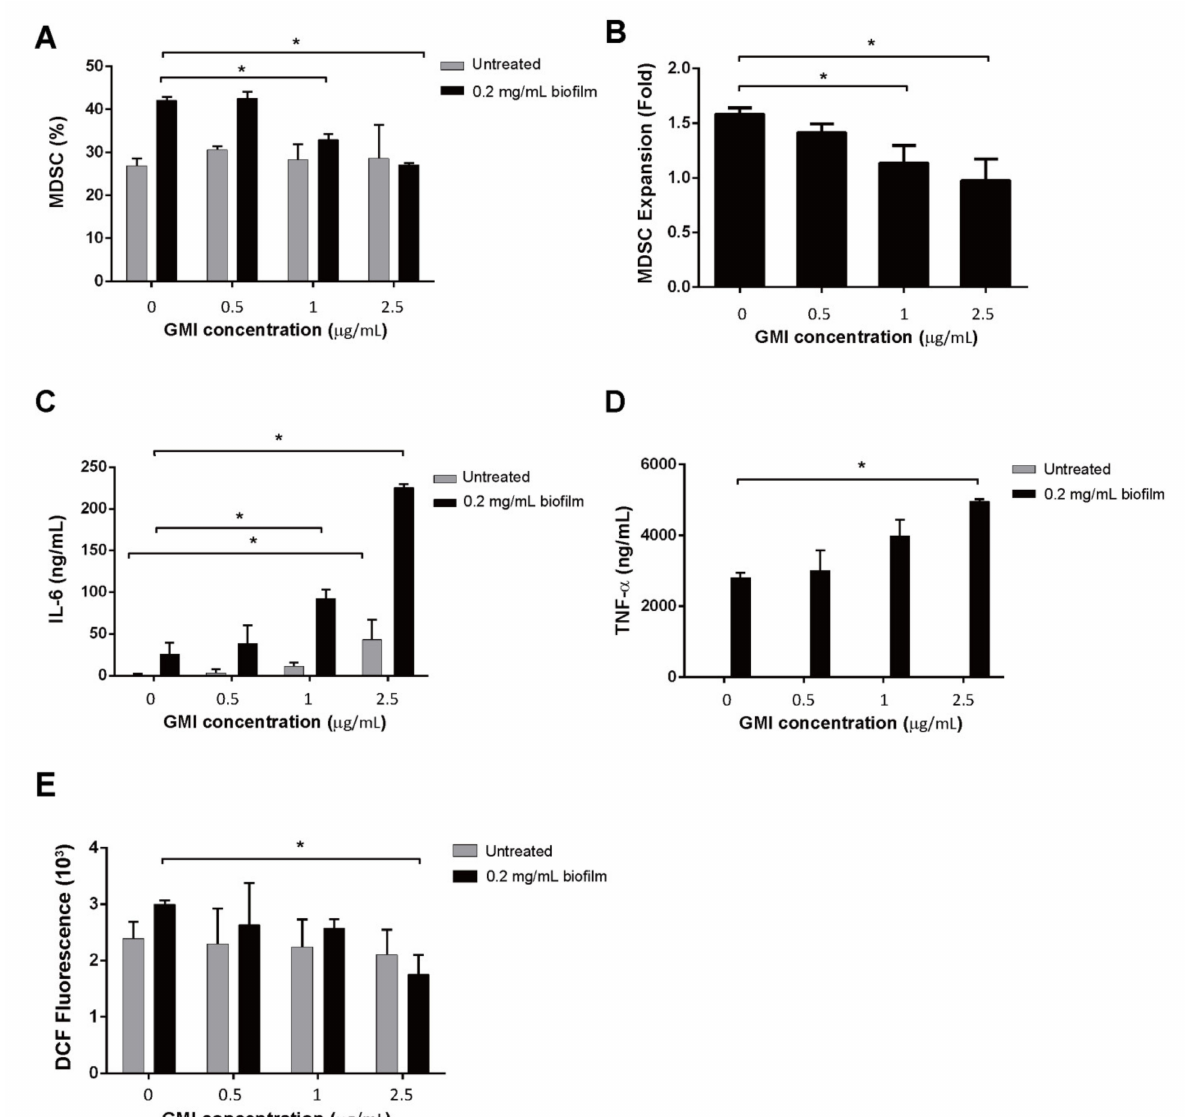
Figure 1. Influence of GMI on MDSC expansion and IL-6, TNF- α , and ROS production. BMCs were treated with S. aureus biofilms GMI for 48 h. BMCs were also untreated with the biofilm but treated with GMI for the purpose of comparison. The number of MDSCs, which were CD11b-FITC an Gr1-PE positive, were determined by cell sorting with a cell sorter. The percentage of MDSCs in the whole cell population was presented ( A ). The number of MDSCs from BMCs treated with biofilms was divided by those untreated with biofilms to show the fold increase in the enhancement of MDSC expansion by biofilms ( B ). The amounts of IL-6 and TNF- α produced by the cells were determined using a CBA kit followed by flow cytometry. ( C , D ). Cells were treated with 10 µ M DCFDA, cell population with ROS production was determined by flow cytometry ( E ). The results were analyzed statistically with Student’s t -test. *: p <